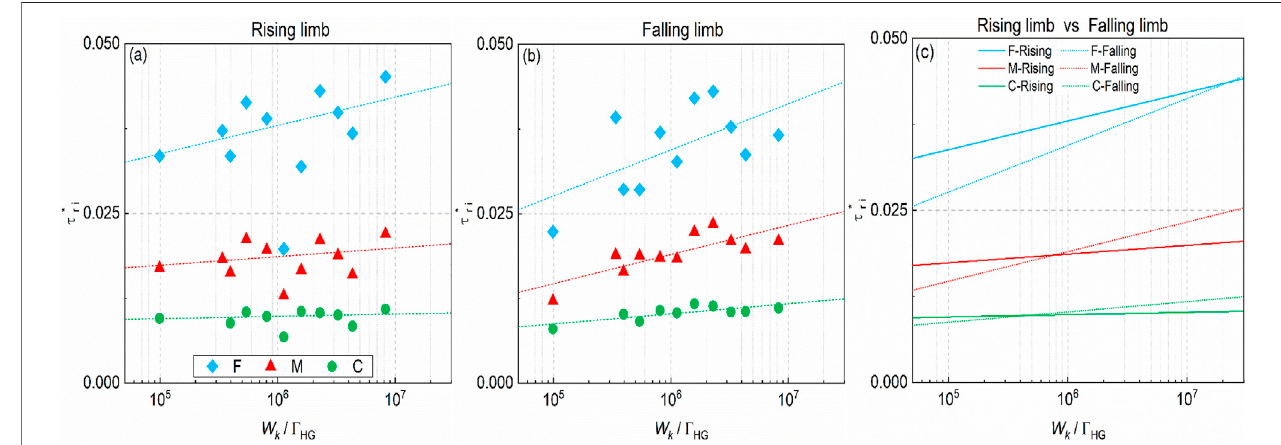
FIGURE 6 | Dimensionlessreferenceshearstressesfor fi ne F ,medium M andcoarse C sizeclasses,groupedbyrising (A) andfallinglimbs (B) andtheir fi ttedtrendcurves takentogether (C) inallsymmetricalhydrograph fl owswithvarying W k / Γ HG values.Note:bedloadtransportratesmeasuredoverrisinglimbinrunV1bisanoutlierandexcludedfor best- fi t regression (This outlier is attributable to an exceptional, unstable bed surface that leads to substantial sediment mobilisation at the beginning of this run).